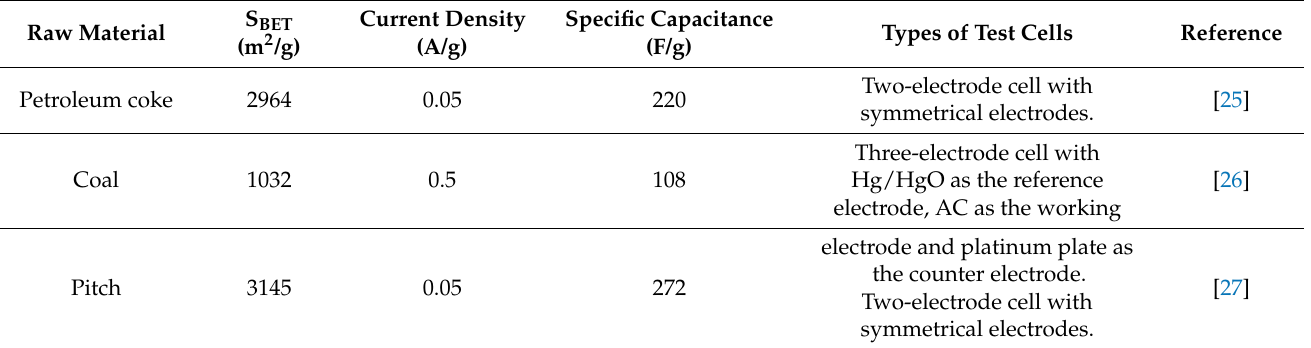
Table 1. Fossil fuels obtained activated carbons for supercapacitor